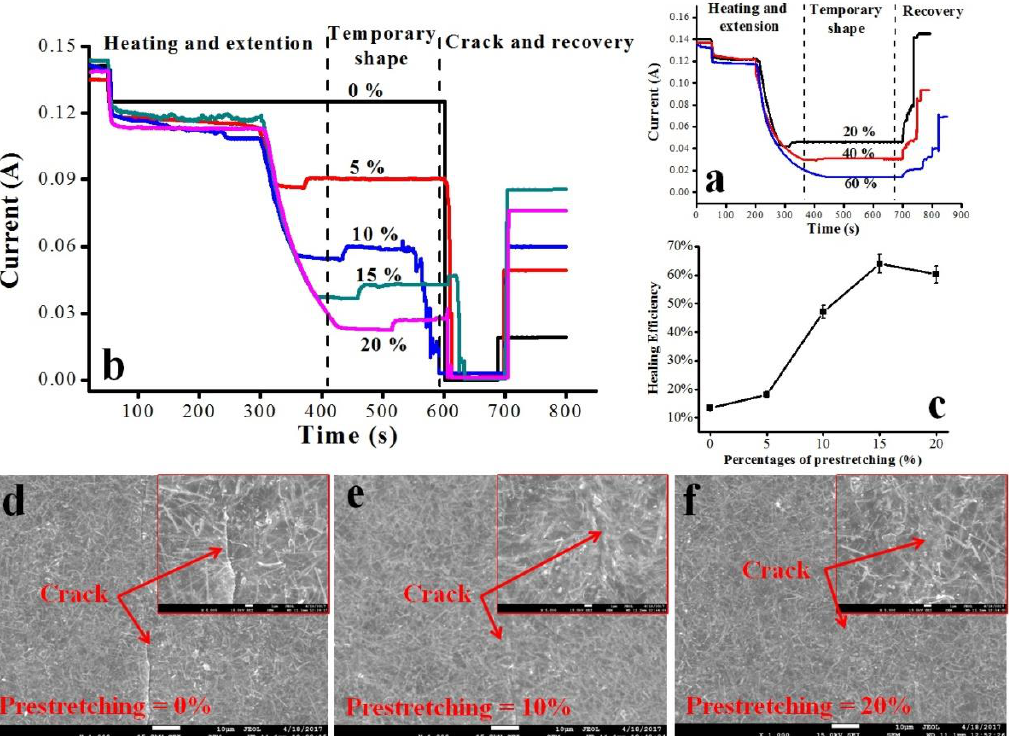
Figure 2. The plots of the current against time for the crack-free samples ( a ) and those exposed upon scratch ( b ) in the healing process; ( c ) The plot of healing efficiency against the pre-stretching percentages; ( d – f ) SEM images for the healed surface morphologies (triggered at 80 °C for 10 minutes) with different pre-stretching percentages.